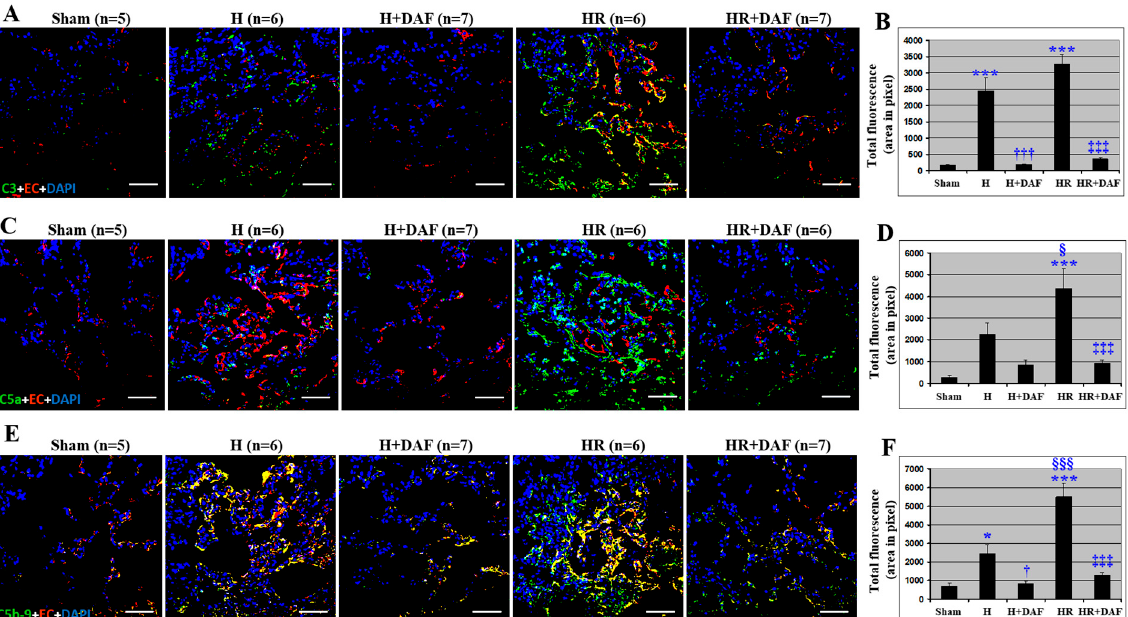
Figure 3. DAF inhibits deposition/generation of C3, C5a, and C5b ‒ 9 in rats subjected to hemorrhagic shock. C3 deposition. ( A ) C5a generation. ( C ), and C5b ‒ 9 formation. ( E ) on the lung endothelium were determined by immunohistochemistry using anti ‒ C3, anti ‒ C5a, anti ‒ C5b-9, and anti ‒ endo- thelial cell antibodies. Quantitative data of C3 ( B ), C5a ( D ), and C5b ‒ 9 ( F ) fluorescent signals of the lung tissues were measured by Photoshop and ImageJ software as stated in Materials and Methods. Original magnification ×400. Scale bar = 50 μ m. * p < 0.05 and *** p < 0.001 vs. sham; † p < 0.05 and ††† p < 0.001 vs. H; ‡‡‡ p < 0.001 vs. HR; § p < 0.05 and §§§ p < 0.001 vs. H (one ‒ way ANOVA followed by Tukey’s test).